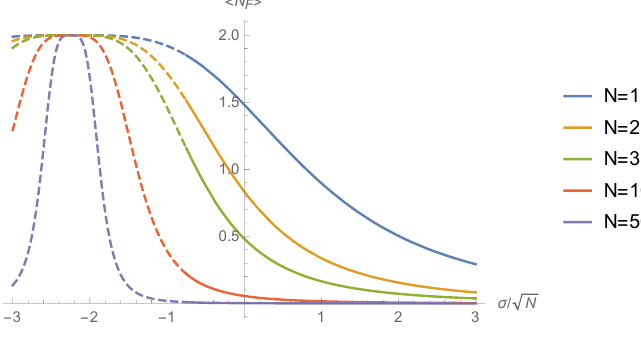
Figure 6 . For a deformation corresponding to turning on a bulk scalar (cid:12)eld, N F ( (cid:27) ).